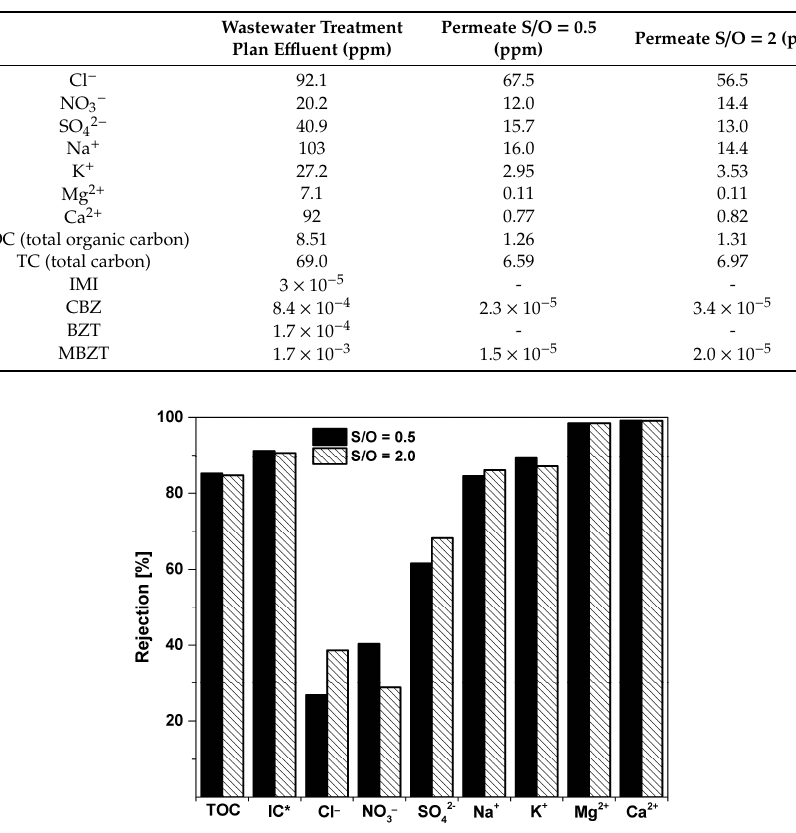
Table 2. Concentration of ions and micropollutants in the wastewater sample as received and after the filtration over the membranes prepared from sols with S/O = 0.50 (Permeate 0.5) and S/O = 2.0. (Permeate 2). The data for imidacloprid (IMI), carbamazepine (CBZ), 1,2,3-benzotriazole (BZT), and 5-methyl-1H-benzotriazole (MBZT) take into account a preconcentration factor of 200 on solid phase extraction (SPE).